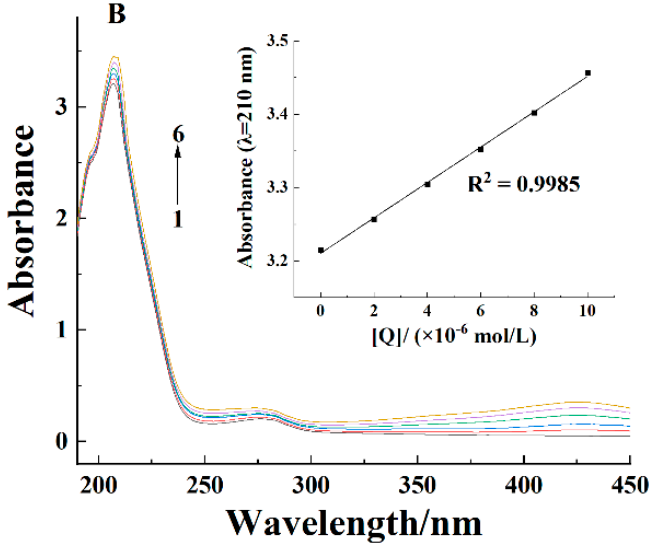
Figure 2. Ultraviolet-visible spectra of casein in the absence and presence of curcumin at 298 K at pH 7.4 ( A ) and pH 2.0 ( B ). The curcumin concentrations in curves 1–6 were 0 × 10 − 6 , 2 × 10 − 6 , 4 × 10 − 6 , 6 × 10 − 6 , 8 × 10 − 6 , and 10 × 10 − 6 mol/L. Casein concentration was 0.2 g/L.